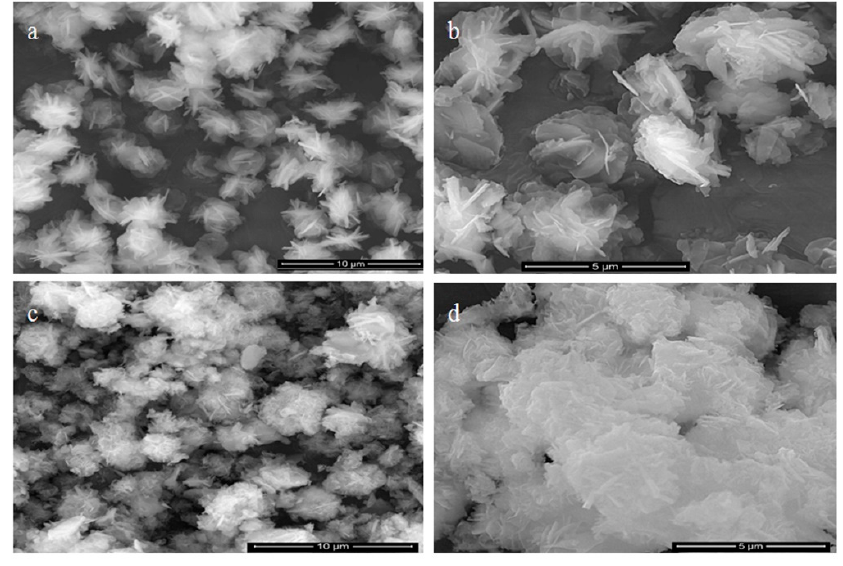
Figure 4. SEM images of ( a , b ) nanohybrid NH2 and ( c , d ) nanohybrid NH3.